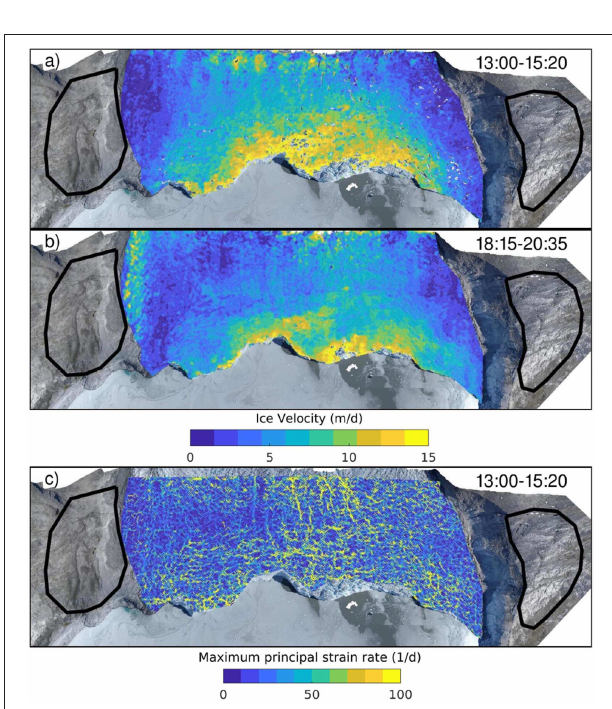
FIGURE 10 | High-resolution (5 m) horizontal ice flow velocity (a,b) and maximum strain rate (c) over 105 min at the front of Eqip Sermia inferred from the ortho-images of repeat survey missions performed on 7 July 2018. Polygons on the glacier sides indicate off-glacier areas used for co-registration.